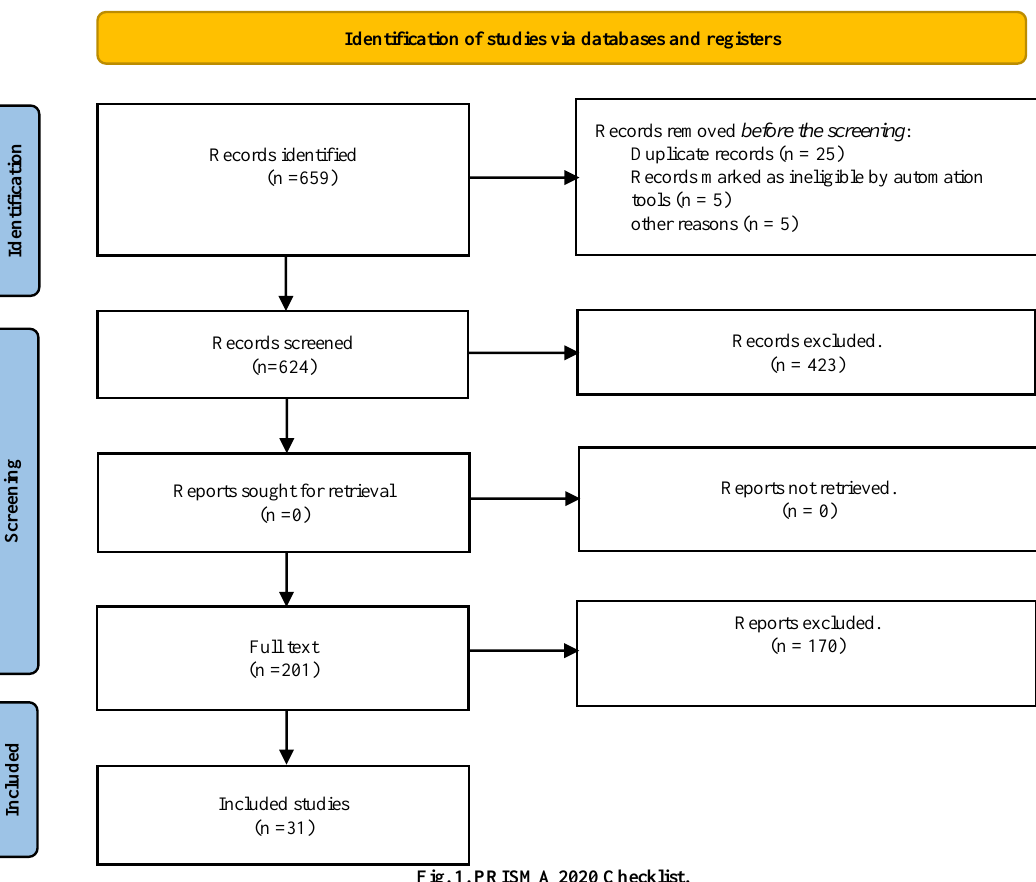
Fig. 1. PRISMA 2020 Checklist.